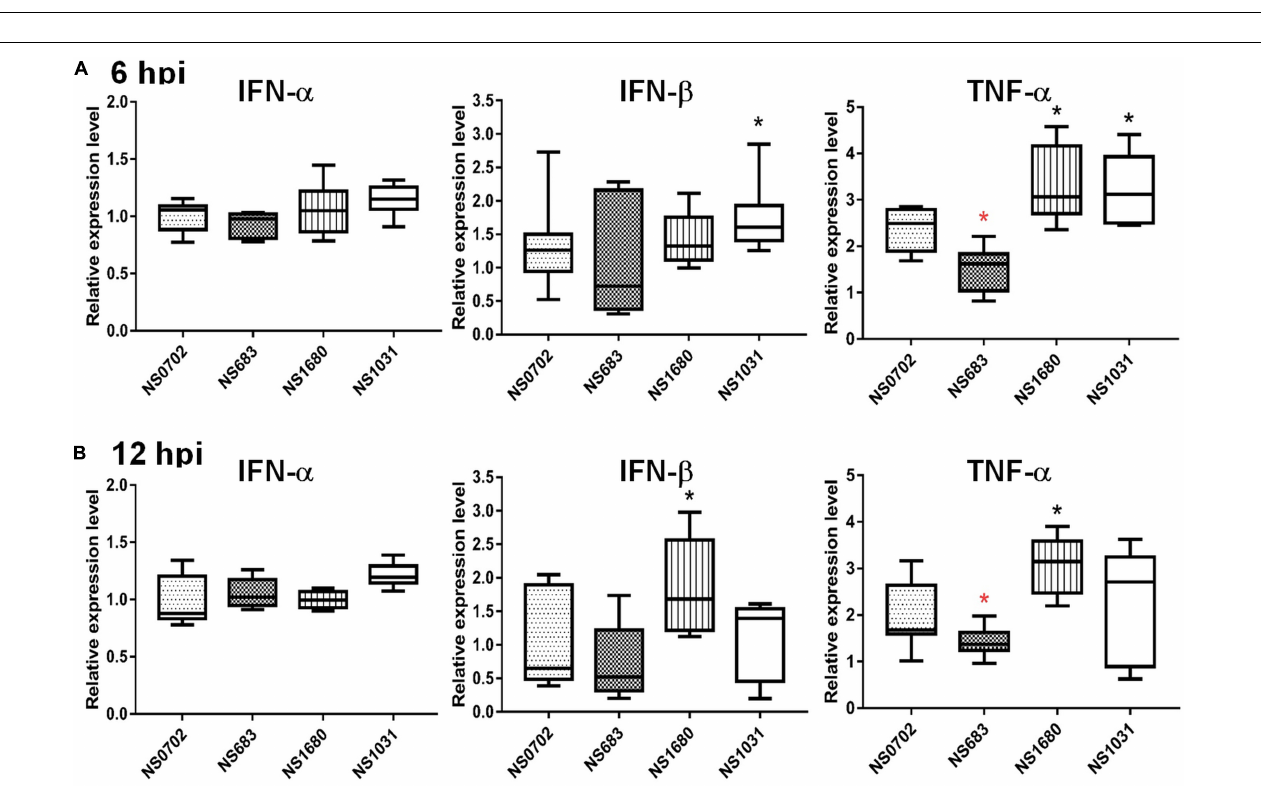
FIGURE 4 | Expression of cytokines in DF-1 cells infected with reassortant avian influenza virus (AIVs). Chicken DF-1 cells were infected by reassortant AIVs at a multiplicity of infection (MOI) of 0.1. Total RNA was extracted at (A) 6 and (B) 12 hpi for detection of cytokine expression (IFN- α , IFN- β , and TNF- α ) by qRT-PCR and normalized with mock infection. *Indicates significant difference ( p < 0.05) in cytokine expression relative to parental virus (NS0702); black and red indicate significantly higher and lower expression,